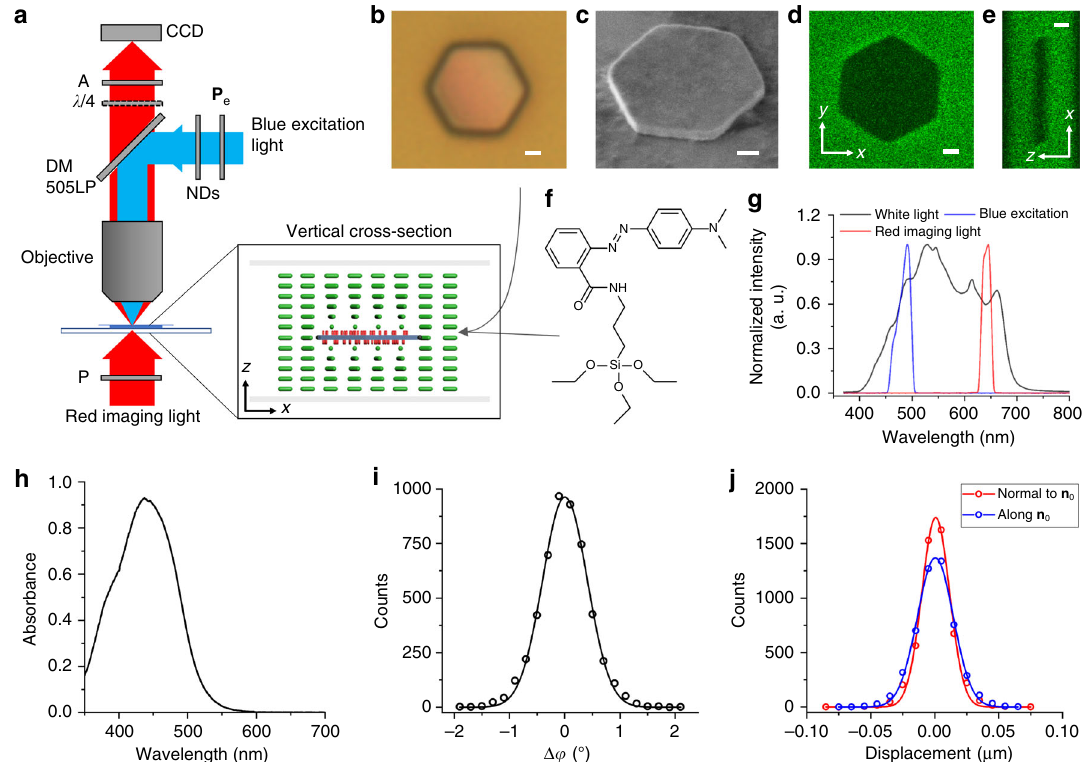
Fig. 10 Experimental characterization of platelets with azobenzene monolayers. a An integrated imaging and excitation setup. White light from a mercury lamp is fi ltered to provide blue excitation light while red light is used for transmission-mode polarizing optical microscopy. P e is a rotatable polarizer used to de fi ne linear polarization direction of the blue excitation light; NDs are neutral density fi lters used to control excitation power. DM is a dichroic mirror re fl ecting the blue excitation light but transmitting the red imaging light. P and A are polarizer and analyzer of the polarizing microscope, respectively. λ /4 is a broadband quarter-wave plate used for polarimetric imaging. Inset shows a schematic of a cell with a particle. b Optical micrograph of a platelet on a substrate obtained without polarizers. c Scanning electron microscopy image showing that the silica platelets used for probing rotational dynamics is about 0.5 μ m in thickness. d , e Three-photon excitation fl uorescence microscopy 37 images of a cell with a platelet in its midplane obtained d , for the cross- sectional plane passing through the platelet ’ s middle and e , for the vertical plane orthogonal to the plane of cell and platelet ’ s large area faces, passing through the platelet ’ s center of mass. f Chemical structure of the used derivative methyl red molecule containing azobenzene moiety. g Normalized spectra of the red and white imaging light and blue excitation incident light used in experiments. Scale bars are 1 µ m. h Absorbance spectrum of the used photosensitive molecules of derivative methyl red in toluene at concentration of 5 × 10 − 5 M. The spectrum was obtained using a 1-cm-thick cuvette and a spectrometer Cary 500 (from Varian). i A histogram quantifying the angular diffusion of a platelet in a plane containing n 0 . Experimental data are fi tted to Gaussian distribution (black line) to obtain an angular diffusion constant of D φ = 1.2 (°) 2 s − 1 = 3.8 × 10 − 4 rad 2 s − 1 . j Translational diffusion of a platelet in a sample plane containing n 0 . Gaussian fi tting yields the diffusion constants measured for the translations normal to and along n 0 : D ⊥ = 0.88 × 10 − 3 µ m 2 s − 1 , D = 1.5 × 10 − 3 µ m 2 s − ||